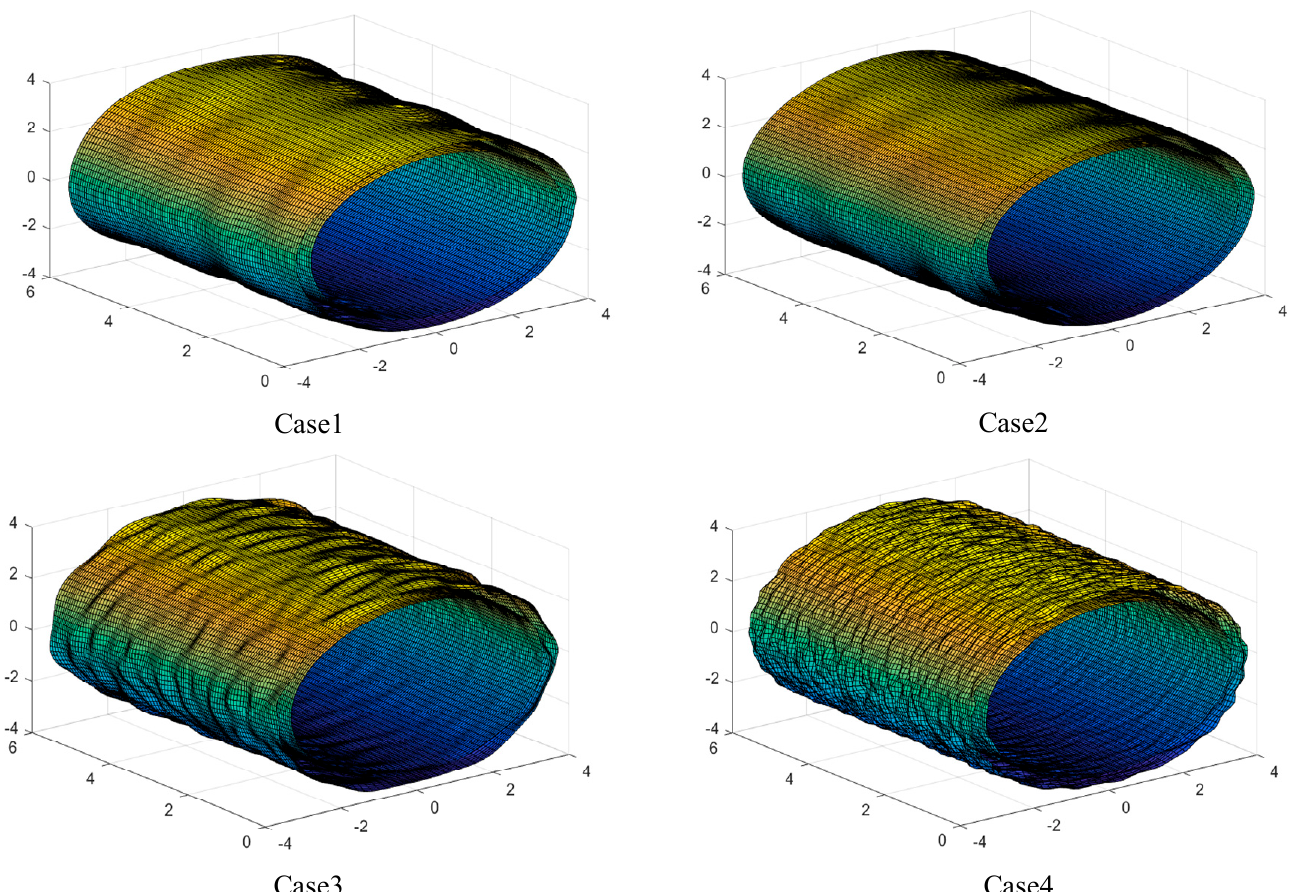
Figure 6. Geometrical topography of the assembly interface of precision spool valve.